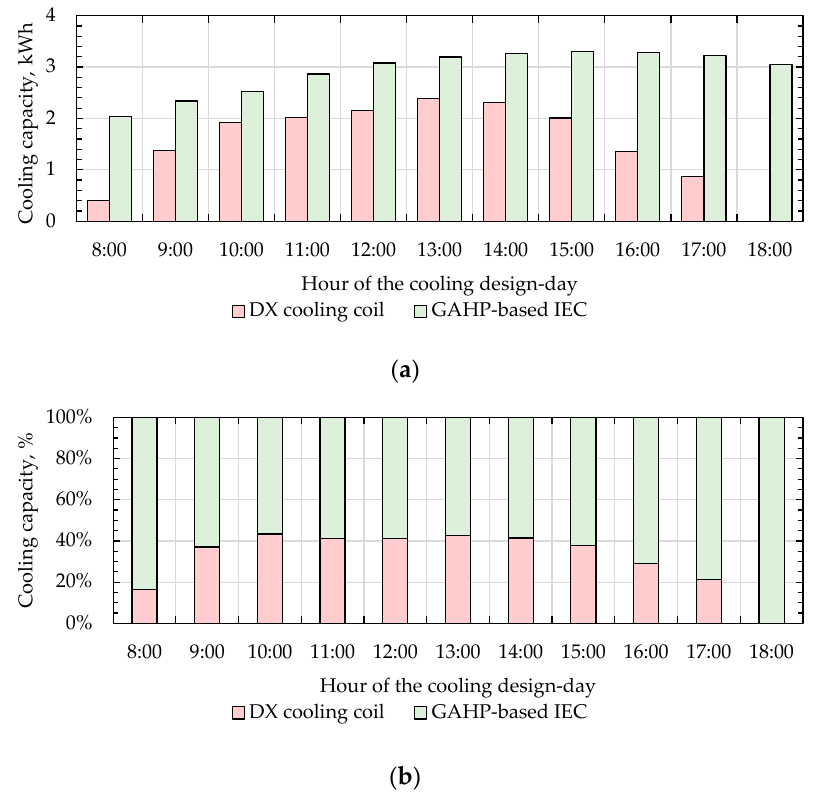
Figure 10. The cooling capacity of System 2: ( a ) the values; ( b ) the share covered by each component.